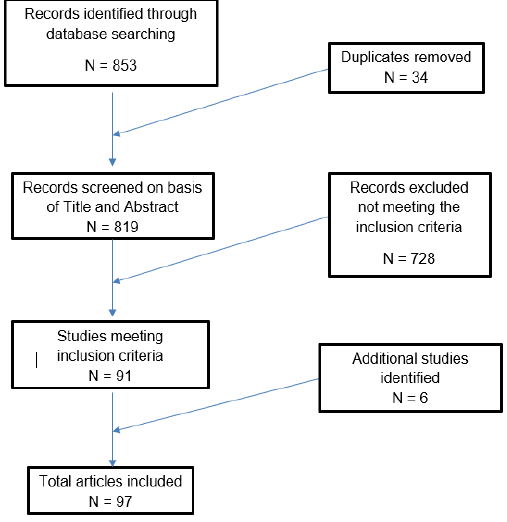
Figure 1. Literature search and article selection.